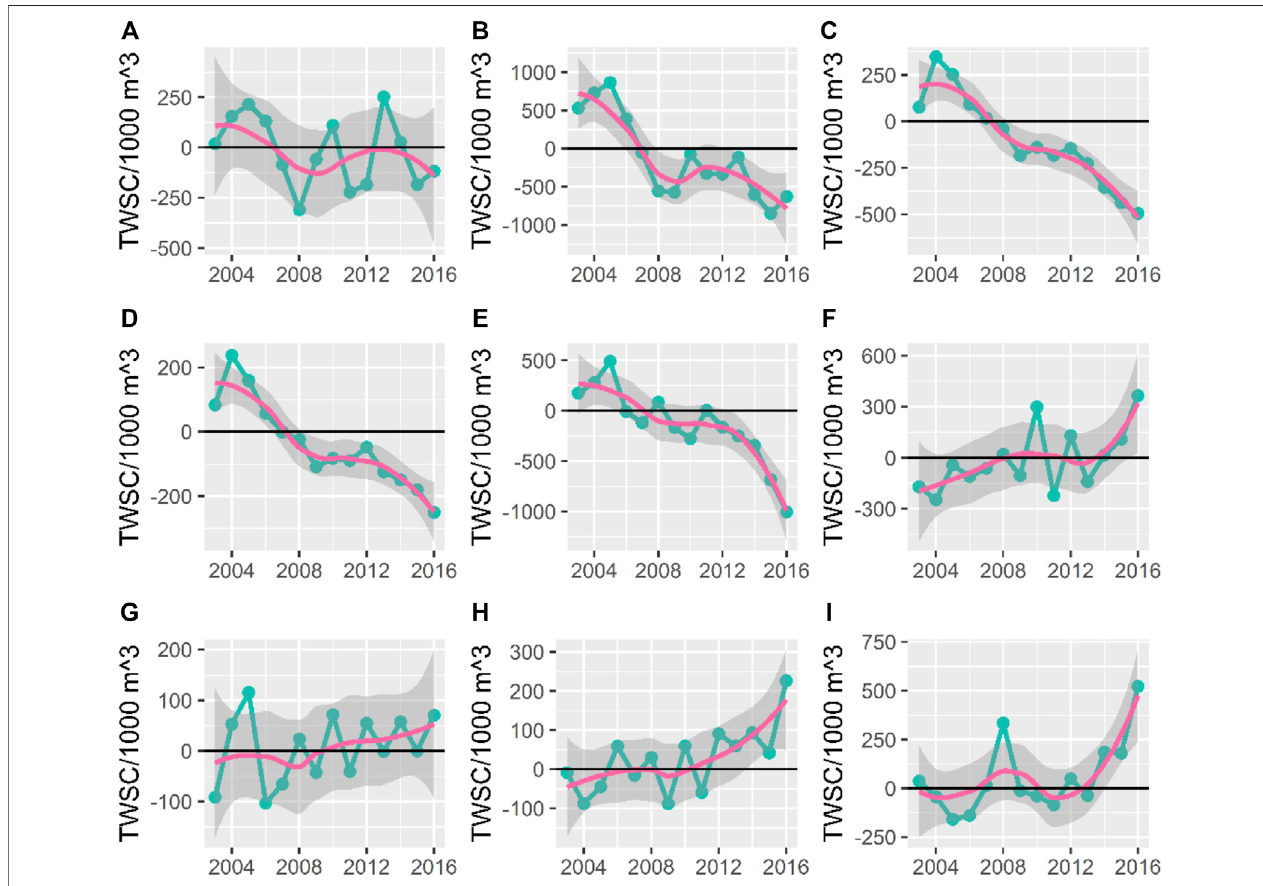
FIGURE 3 | GRACE time series plot of yearly sum with Trend Line from 2003 to 2016 in nine agricultural regions. [ (A) Northeast China Plain, (B) Northern arid and semi-arid region, (C) Huang-Huai-Hai Plain, (D) Loess Plateau, (E) Qinghai Tibet Plateau, (F) Middle-lower Yangtze Plain, (G) Sichuan Basin and surrounding regions, (H) . Southern China, (I) Yunnan-Guizhou